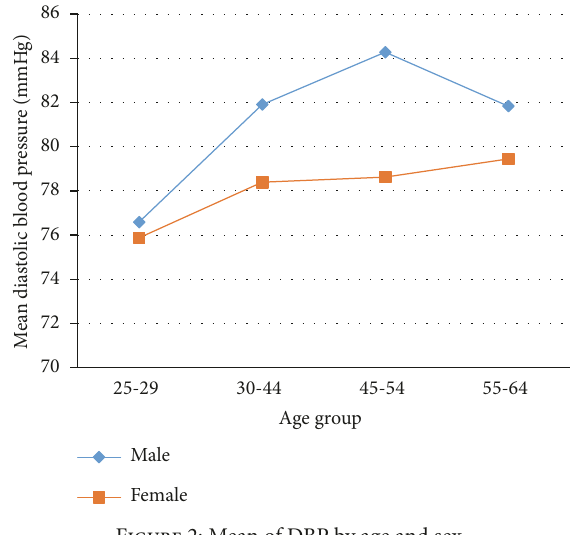
Figure 2: Mean of DBP by age and